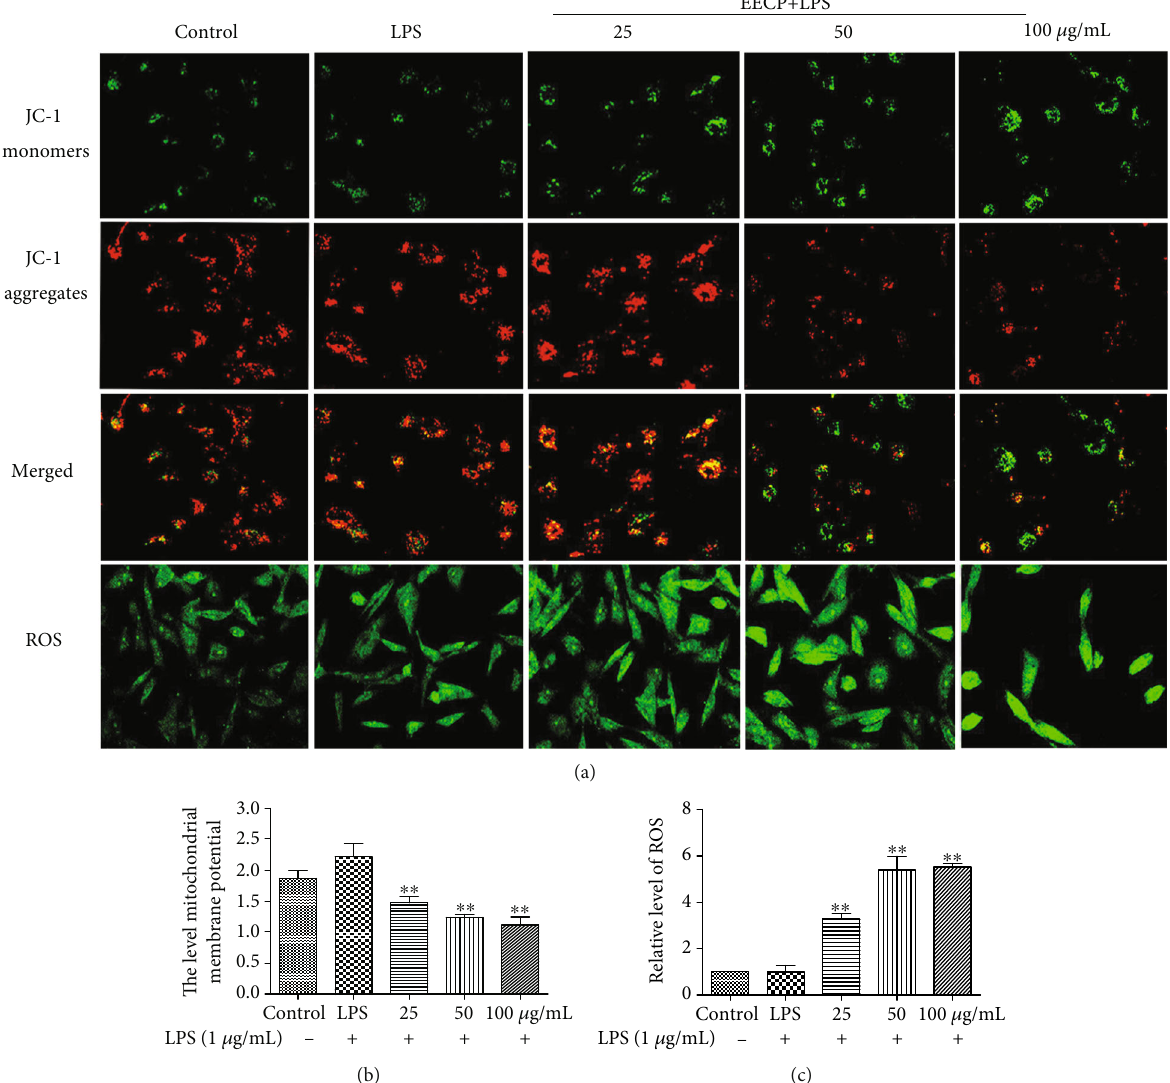
Figure 6: EECP increased reactive oxygen species (ROS) levels and decreased mitochondrial membrane potential in MDA-MB-231 cells stimulated with LPS. (A) Fluorescence micrographs obtained at 24h. (b, c) Values represent the relative fl uorescence intensity per cell determined by laser scanning confocal microscopy. Values represent the mean ± SEM from three independent experiments ( ∗ P < 0 : 05 ∗∗ P < 0 : 01 , vs. control, n = 3